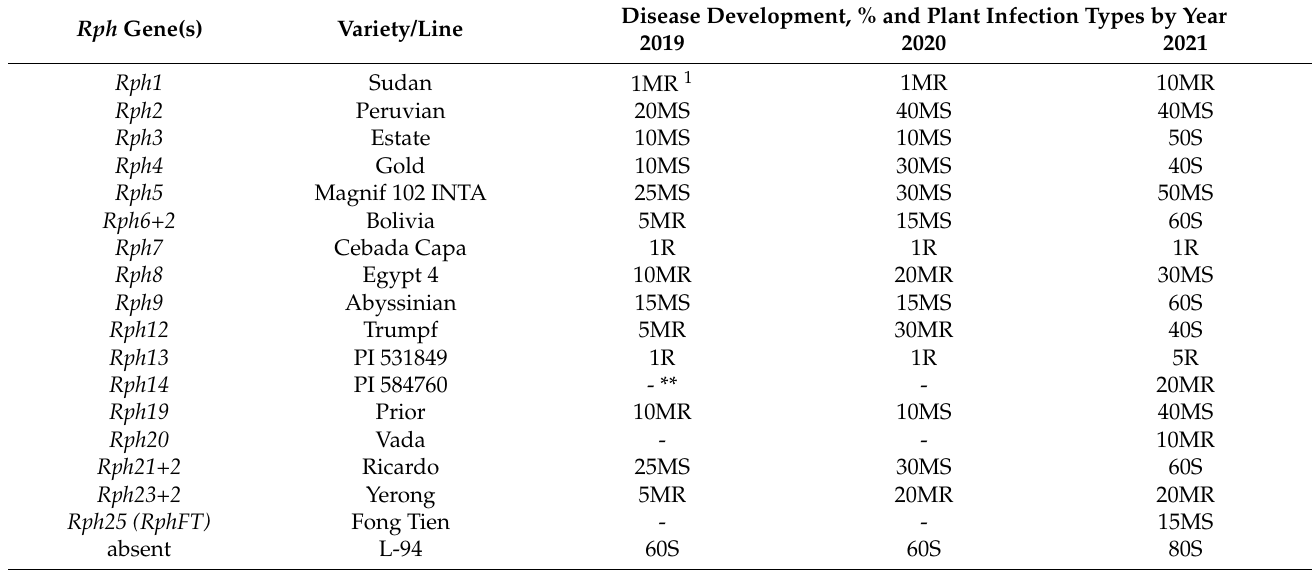
Table 1. Immunological evaluation of barley varieties and lines with known R genes ( Rph ) to P. hordei in Southern Russia (FRCBPP infectious nursery, 2019–2021).